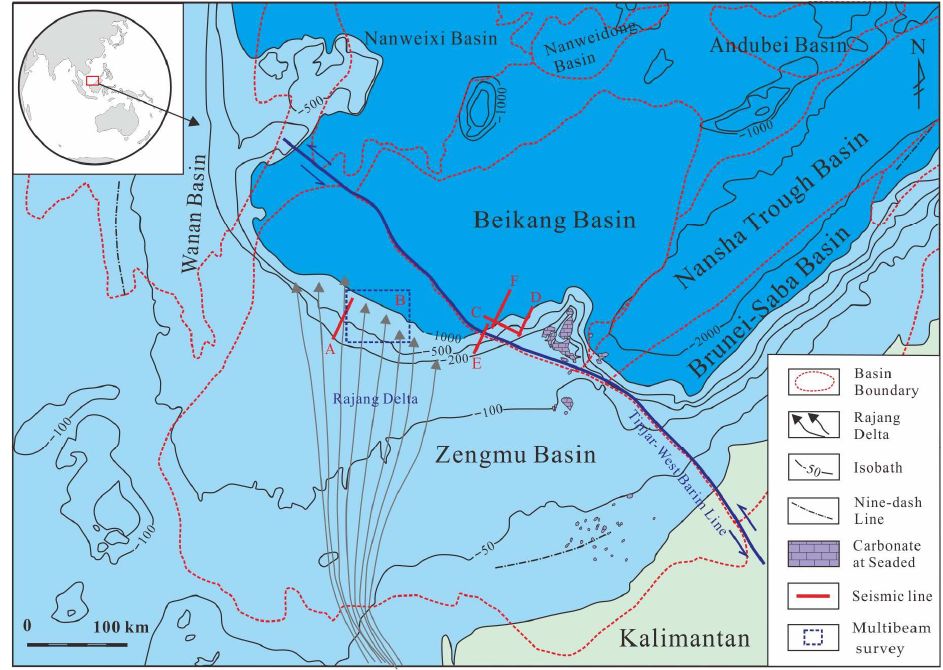
Figure 1. Location of the study area and seismic profile of the southern margin of the South China Sea. The location of A–F in Figure 1 correspond to the position of Figures 2–7 in order. Carbonate platforms mapped in the Zengmu Basin are from Eduard et al., [12]. The Tinjar-West Baram Line marked by the dark blue line is from the fault patterns of Clift et al., [26], Cullen [27] and Zhao et al., [31]. The Rajang Delta mapped with the gray arrows is from Hutchison [28]. The position of multibeam survey as B is from Huang et al., [8]. The red lines are the locations of seismic sections showing different potential geological hazards.